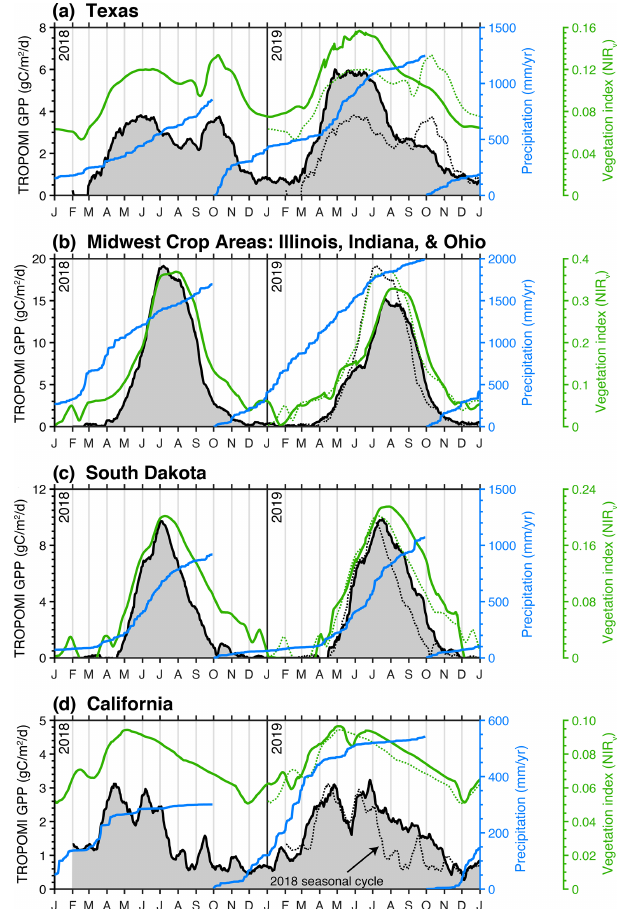
Figure 4. Major drivers of interannual variability in CONUS GPP. Black line shows the TROPOMI-derived GPP over Texas (a) , the midwestern crop region (b) , South Dakota (c) , and California (d) . Blue line shows the cumulative precipitation over the water year as measured by the GPM satellite. Green line is NIR v from MODIS. Black and green dotted lines are 2018 GPP and NIR v superimposed on the 2019 time series.